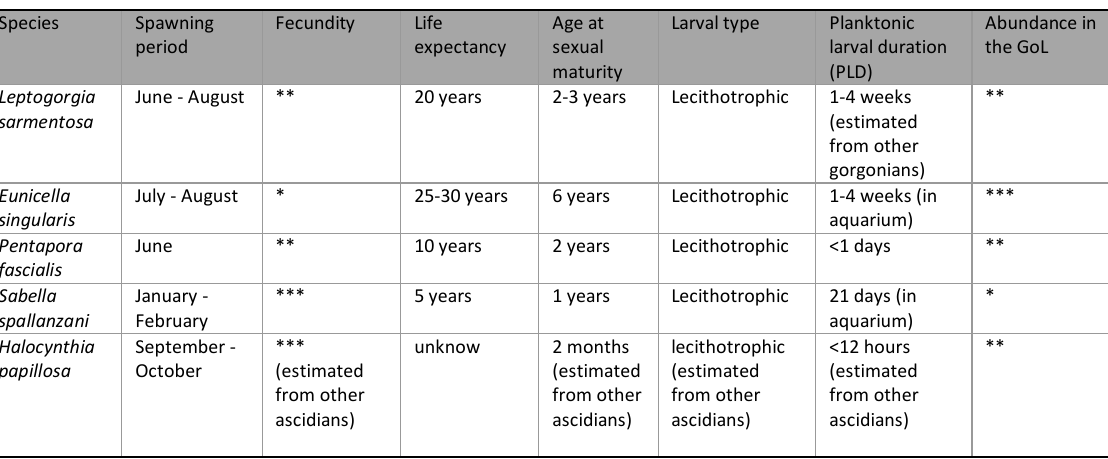
Table 1: Life history traits (spawning period, relative fecundity, life expectancy, age at sexual maturity, larval type, planktonic larval duration (PLD), relative abundance in the GoL) for the five species inventoried on ARs.